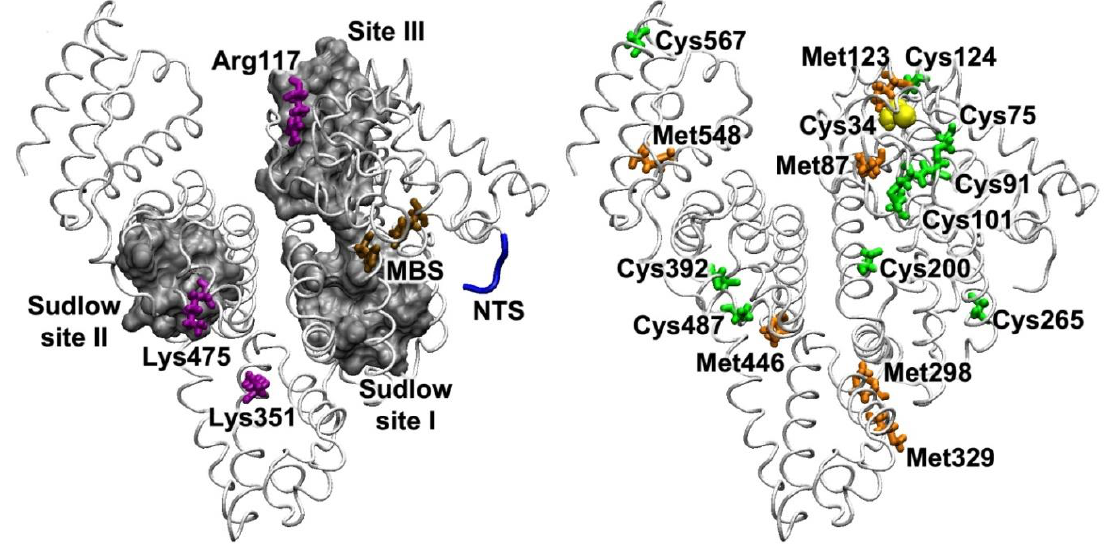
Figure 6. The main binding sites of HSA and the amino acids that are responsible for the participation of albumin in redox reactions. Left: dark gray surface shows the areas of major albumin binding sites—Sudlow site I, Sudlow site II and Site III (see Section 2); the N -terminal site (NTS, Asp-Ala-His-Lys) is shown in blue; the metal-binding site (MBS, His-67 and His-247) is shown in brown; the amino acids involved in the binding of polyunsaturated fatty acids are shown in purple. Right: Cys34 is represented in yellow; six methionine residues are shown in orange; the cysteines within the disulfide bonds that can be reduced when interacting with low-molecular-weight thiols are shown in green. To create the figure, a three-dimensional structure of HSA from the PDB database, code 3JQZ [57], was used.